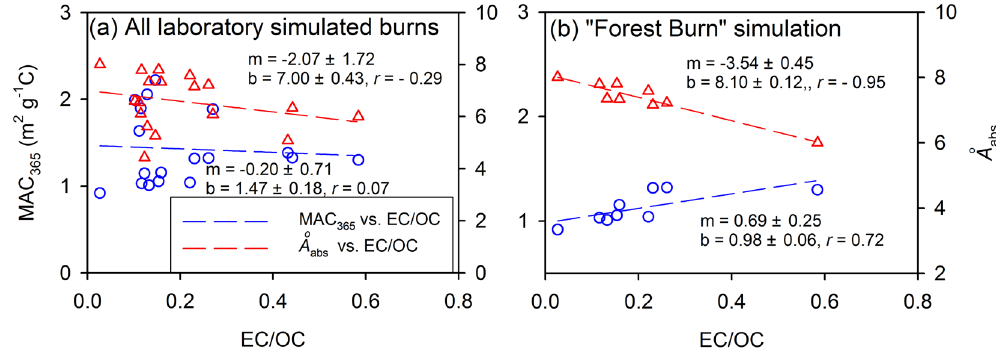
Figure 3. Linear regressions of MAC 365 vs. EC/OC, and Å abs vs. EC/OC for ( a ) all laboratory simulated burns (OBTF) and ( b ) laboratory simulations for “Forest burn”. In each plot, m and b represent regression slope and intercept, respectively, with one standard